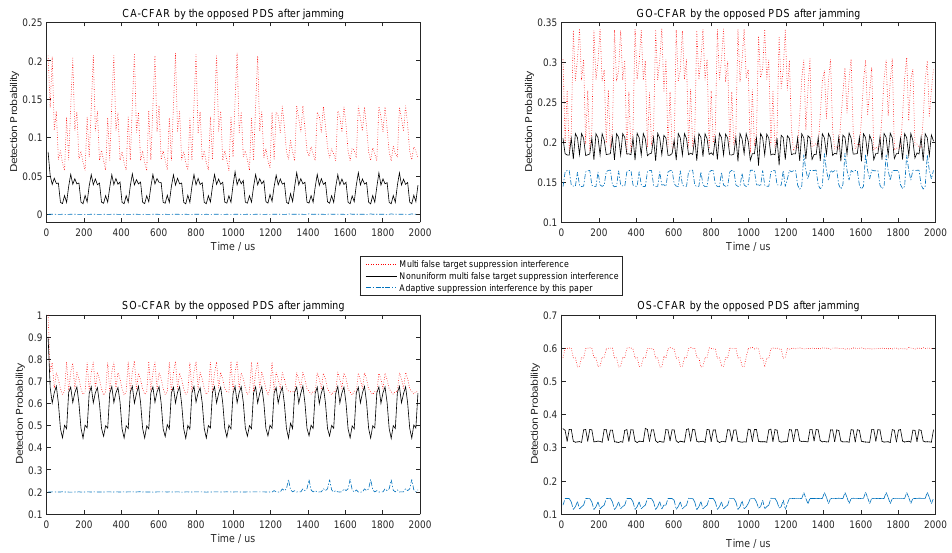
Figure 8. Compared to [31,32], detection probability of CA, GO, SO, and OS-CFAR before and after jamming when the number of reference units is